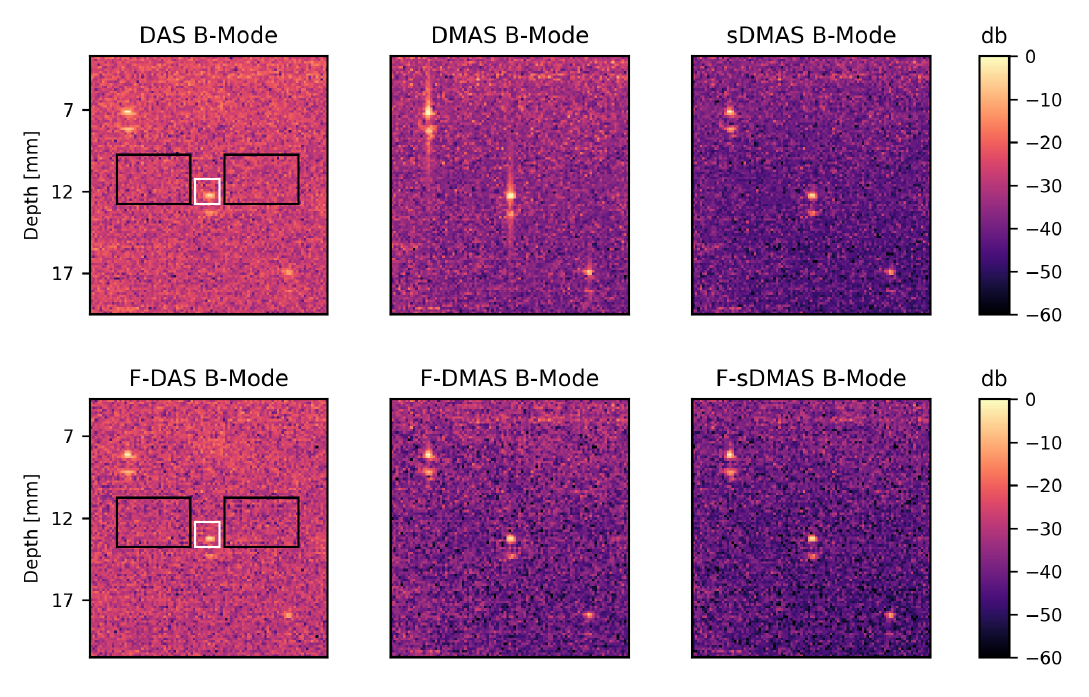
Figure 3. Visualization of B-Mode PA images with logarithmic compression using DAS, DMAS and sDMAS beamforming in the first row, with an additional bandpass filter (F) applied in the second row. The PA signals from the upper and lower boundaries of the tubes are visible with a distance of